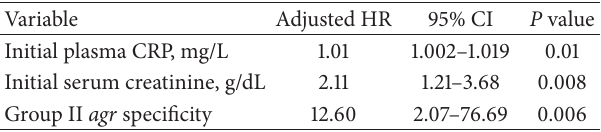
Table 3: Multivariate Cox regression analysis of factors associated with in-hospital mortality in critically ill patients with MRSA bacteremia treated with